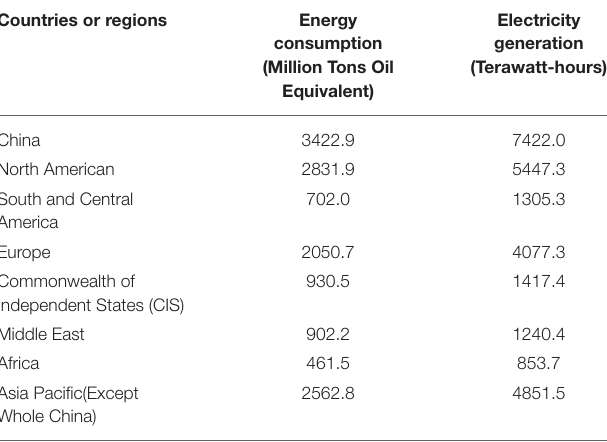
TABLE 1 | Comparison of energy consumption and electricity generation between China and other areas of the world in 2018. Countries or